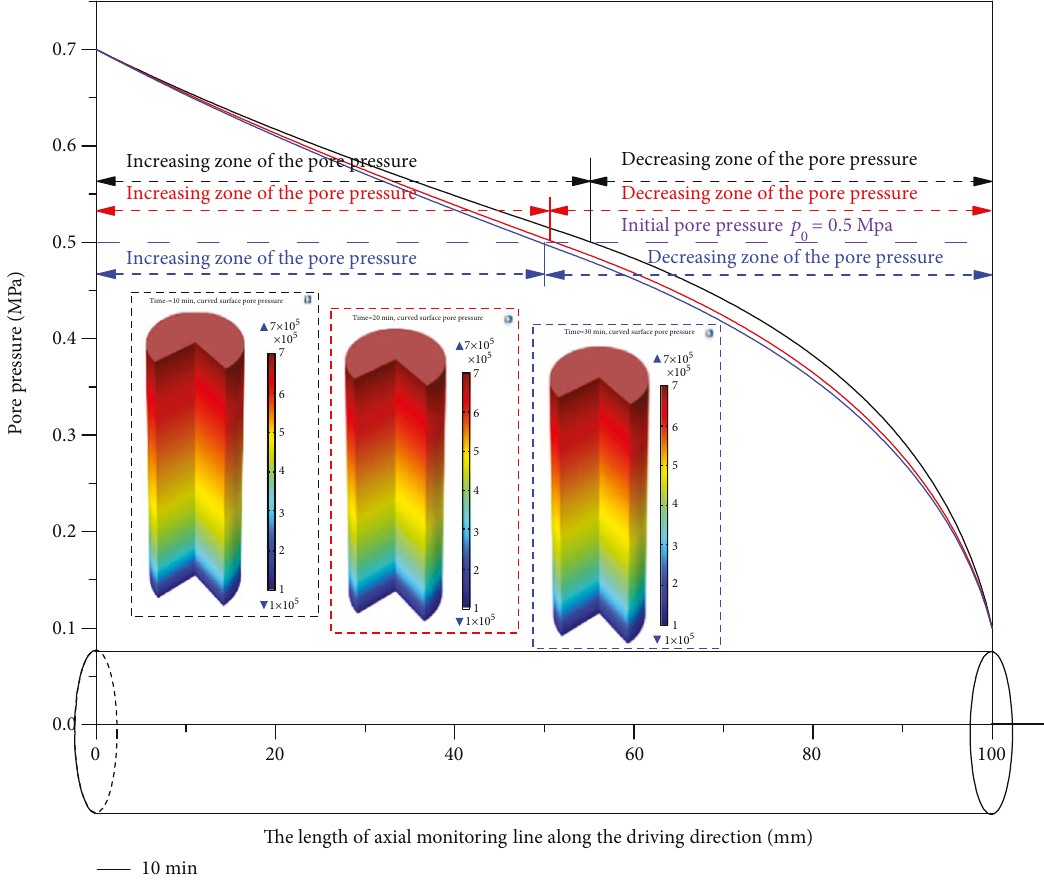
Figure 11: Space-time curve and cloud image of the pore pressure on the axial monitoring line along the driving